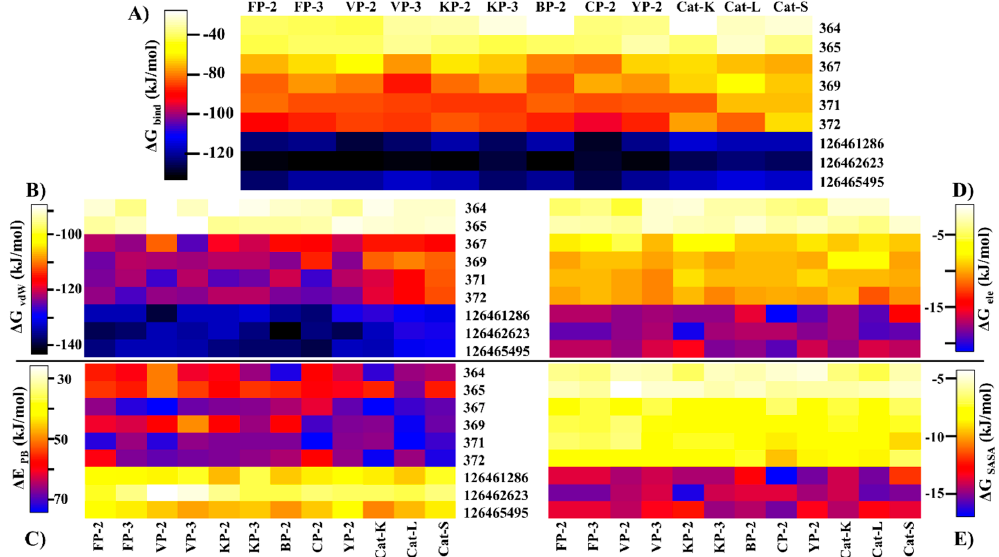
Figure 6. Heatmaps representing the ( A ) binding free energies of the protein-ligand complexes and the contributions from individual energetic components: ( B ) van der Waals (vdW); ( C )